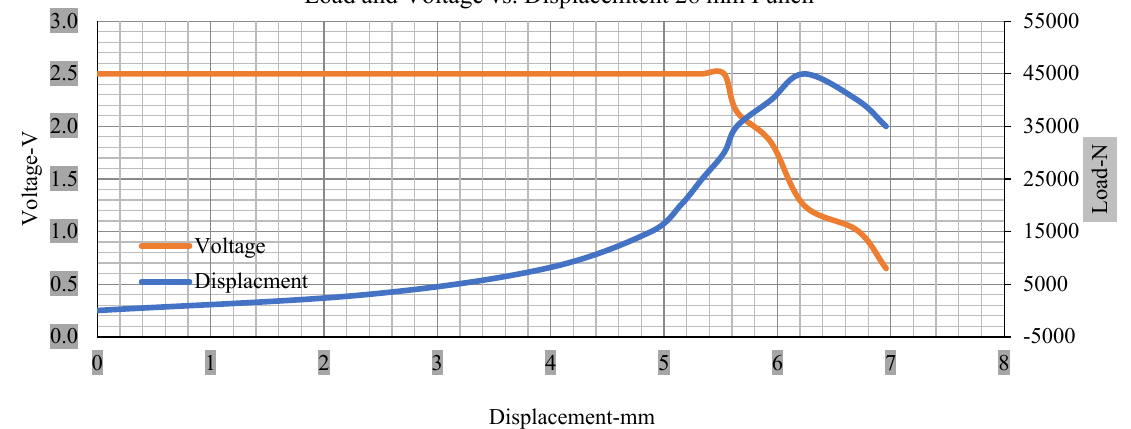
Figure 8. Load and voltage vs. displacement 28 mm punch greater than 10% soc.